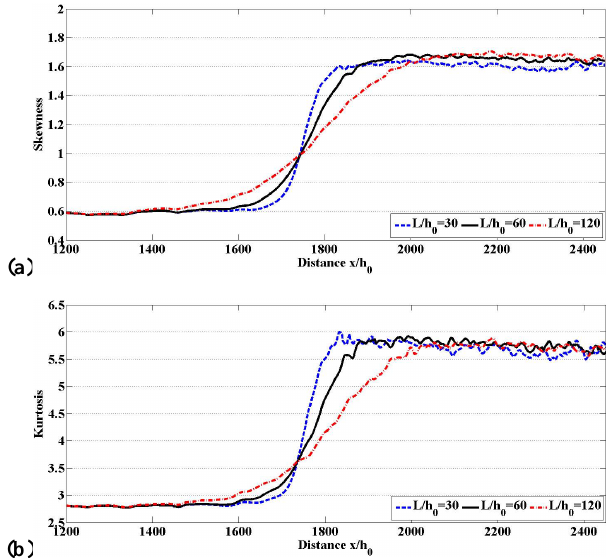
Fig. 7. Transformation of the skewness (a) and the kurtosis (b) for different values of transitional zone L / h 0 , h 0 = 10m, Ur =3.47.